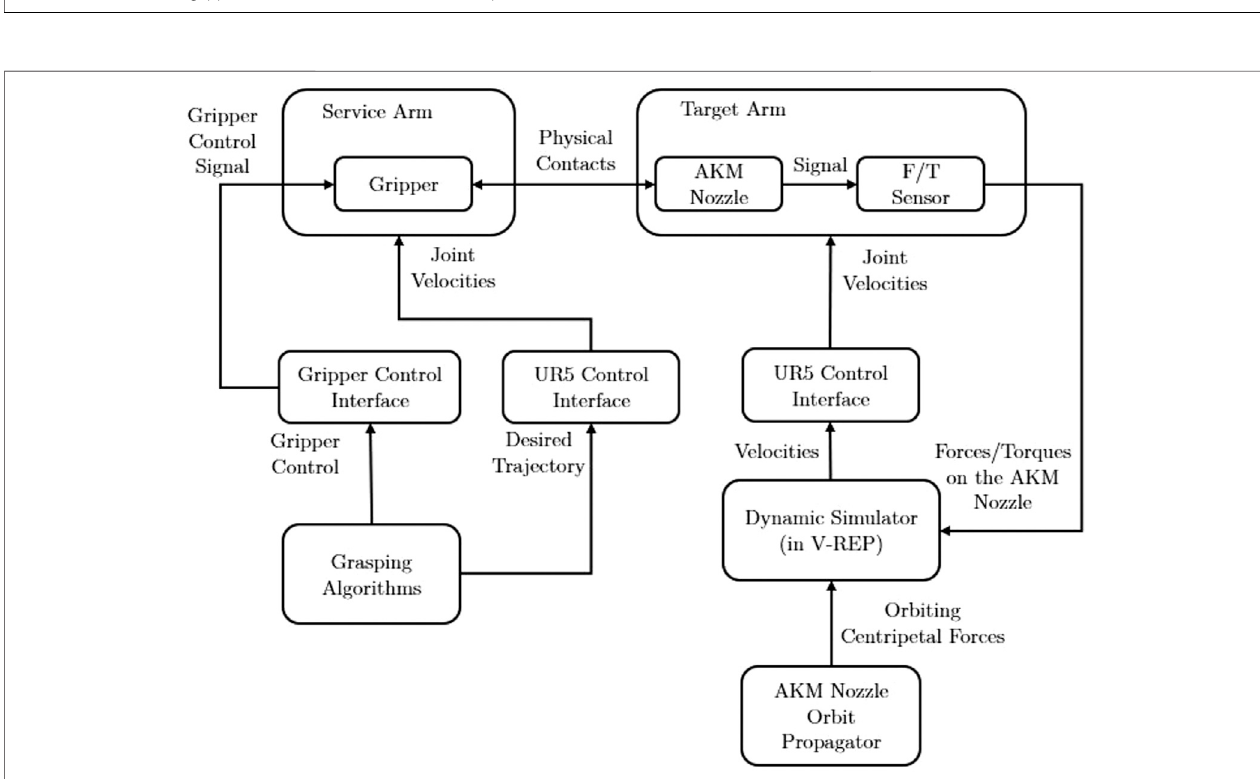
FIGURE 4 | The fl owchart of the STAR LAB ’ s Space Robotics Testbed with the con fi guration for the AKM grasping and pulling hardware-in-the-loop experiment.